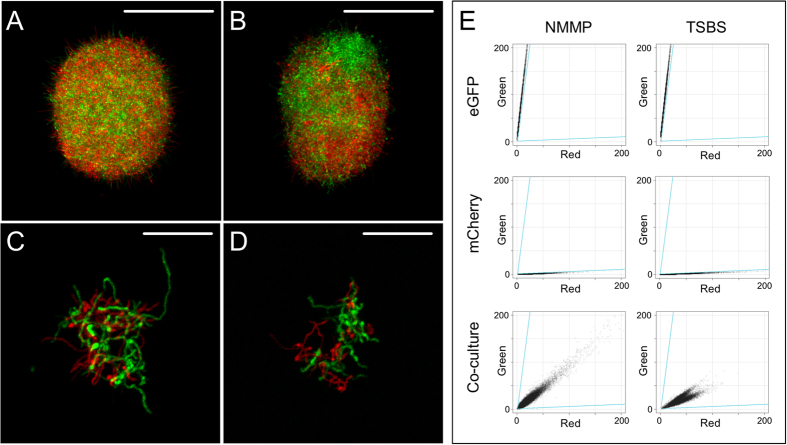
Analysis of aggregation of fluorescent S. lividans strains.Spores of strains expressing eGFP (S. lividans pGreen) or mCherry (S. lividans pRed) were mixed at the onset of growth in NMMP (A,C) or TSBS (B,D). After 24 h of growth, pellets are composed of both types of fluorescent hyphae (A,B). Aggregates of fluorescent germlings are already detected 6 hours after inoculation (C,D). (E) Quantitative analysis of aggregation using particle sorting. Each plot represents the fluorescence intensities of pellets in the red (X-axis) and green (Y-axis) channel. The top two panels show the green:red ratios of pellets from the eGFP-expressing strain in NMMP (left) and TSBS (right) medium, while the middle two panels reveal the green:red ratios of pellets from the strain expressing only mCherry. The bottom panels represent the fluorescence intensities of pellets from the co-cultivations of both fluorescent strains, which indicate that almost all pellets express both reporters. Scale bars represent 100 μm (A,B) or 20 μm (C,D).